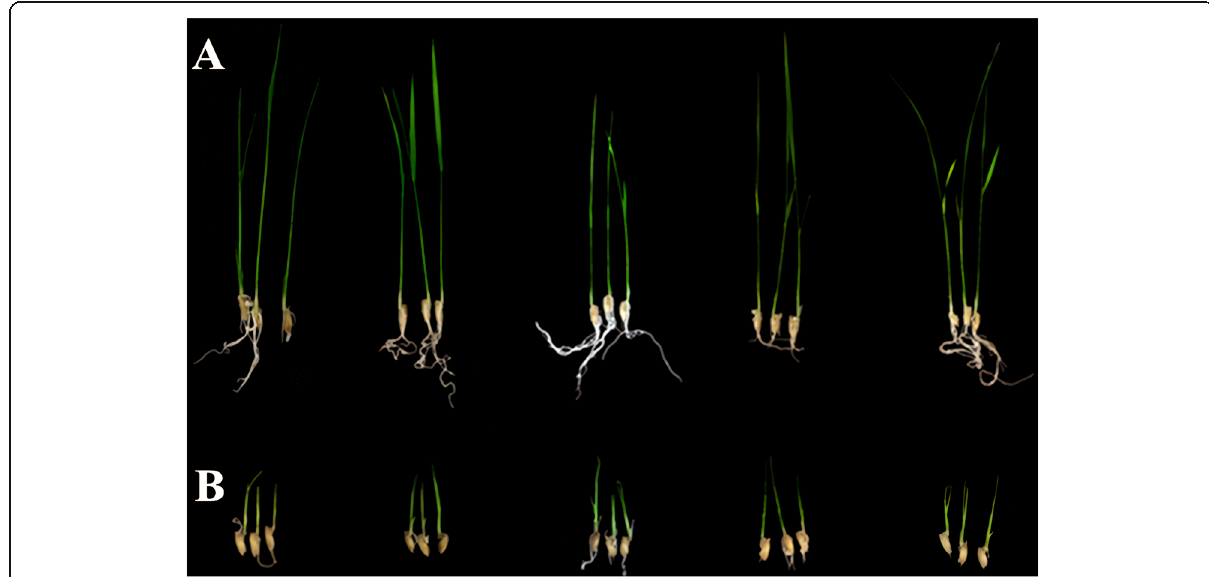
Fig. 3 a The phenotype of 5 F 2:3 plants randomly selected from T-pool after 10 days of 0.5% NaCl treatment. b The phenotype of 5 F 2:3 plants randomly selected from S-pool after 10 days of 0.5% NaCl